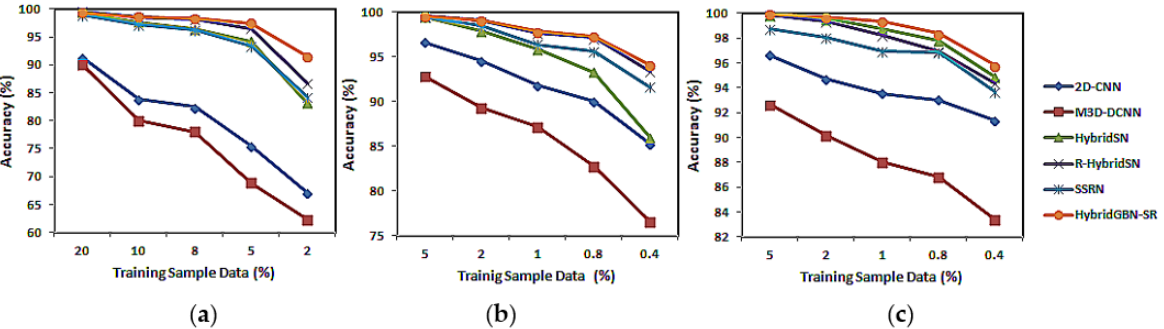
Figure 19. Varying training sample data for ( a ) IP; ( b ) UP; ( c ) SA